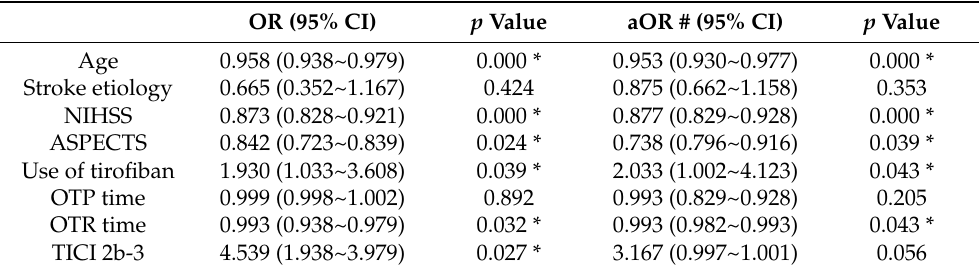
Table 2. Multivariate regression analysis for favorable outcome.